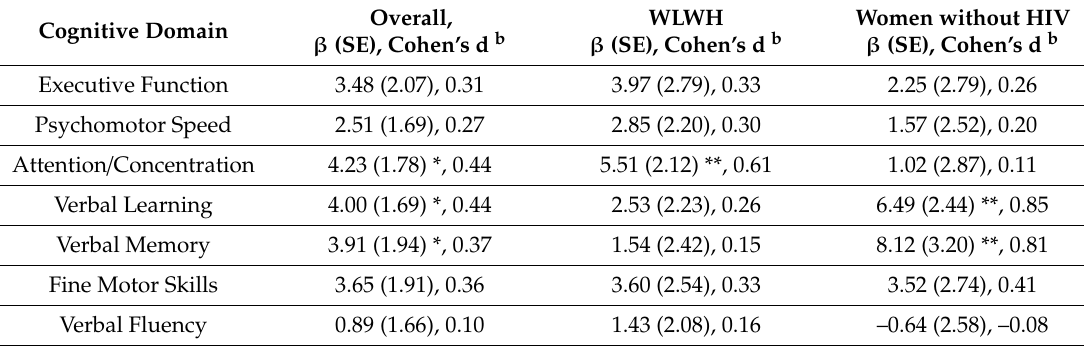
Table 2. Associations of olive oil and cognitive domain t -scores a among women living with and without HIV (human immunodeficiency